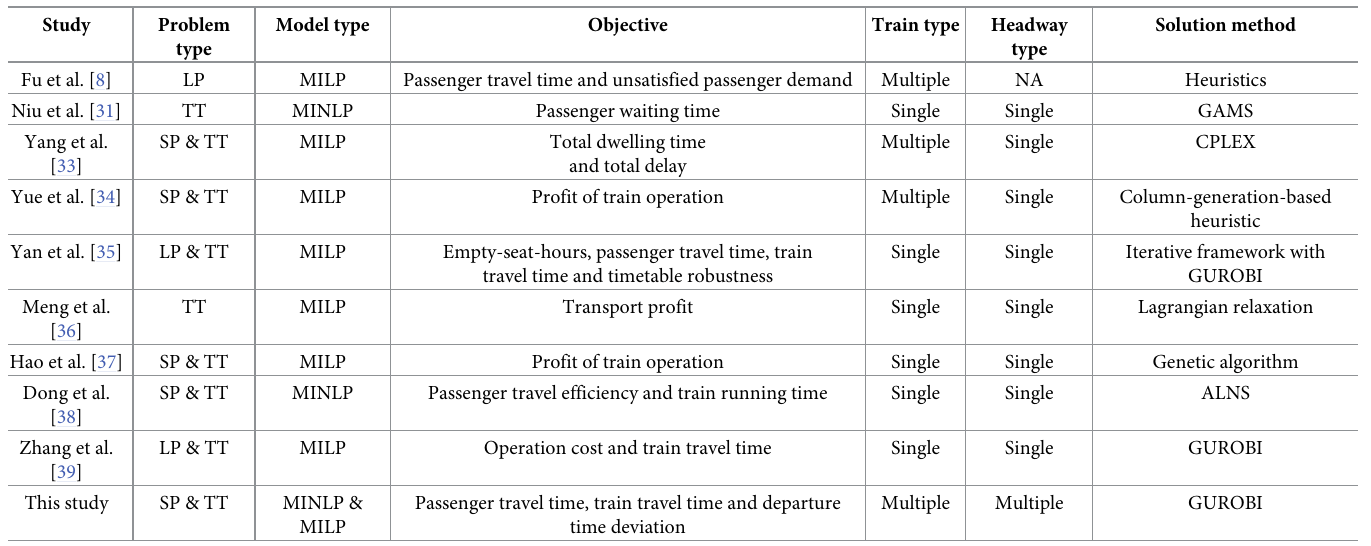
Table 1. Summary of relevant